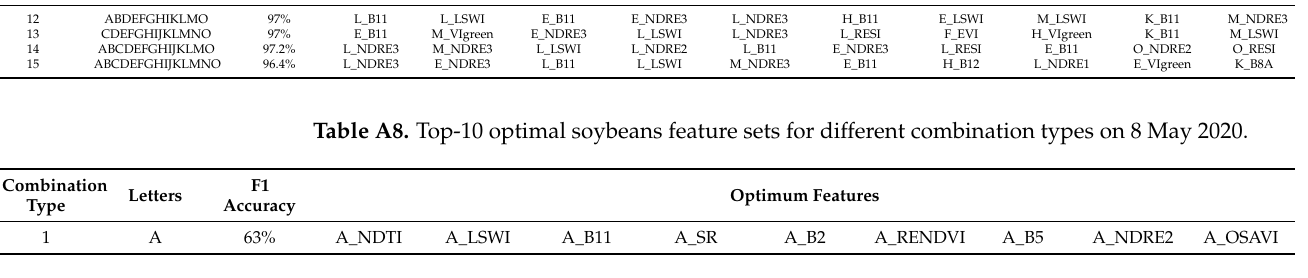
Table A9. Top-10 optimal soybeans feature sets for different combination types on 13 May 2020.